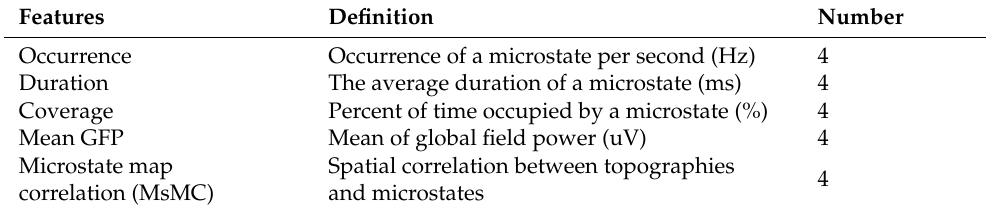
Figure 3. Results of the predictor importance scores for twenty microstate features extracted from resting state EEG recordings of SZ patients and HC subjects. Table 1. Description of microstate predictors that were used in this study.